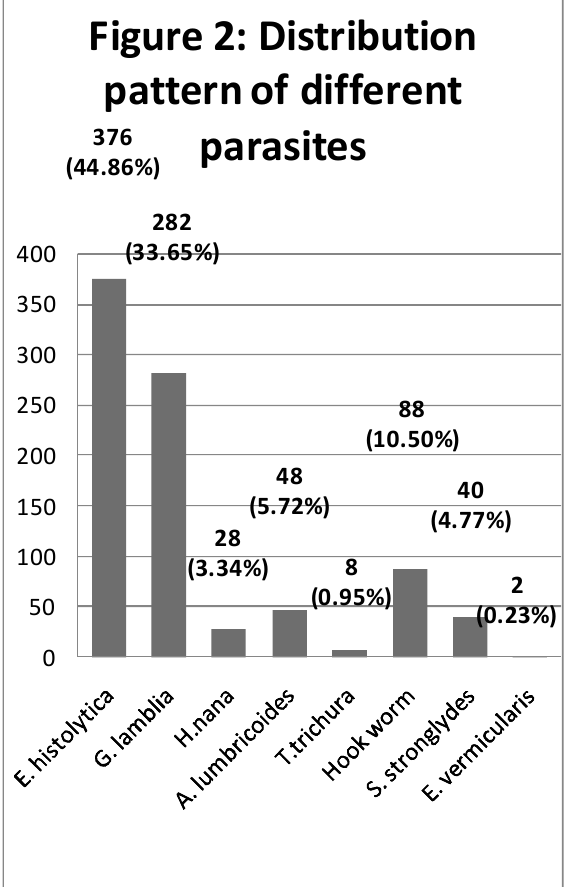
Figure 2: Distribution pattern of different